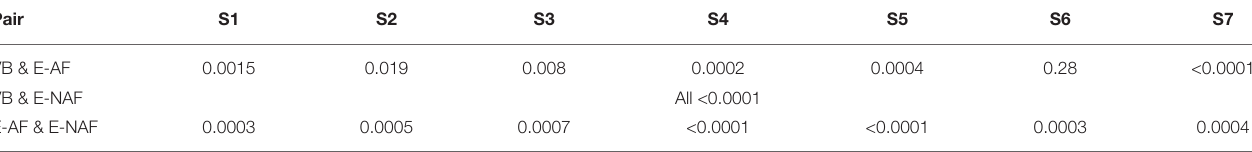
TABLE 3 | In the online phase, the p -value of the three-way pairwise permutation test statistical analysis. Pair S1 S2